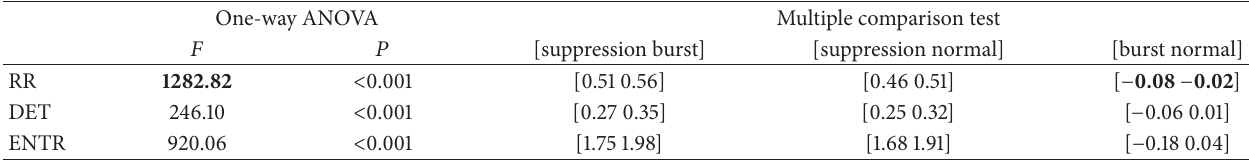
Table 1: One-way ANOVA and multiple comparison test of three RQA